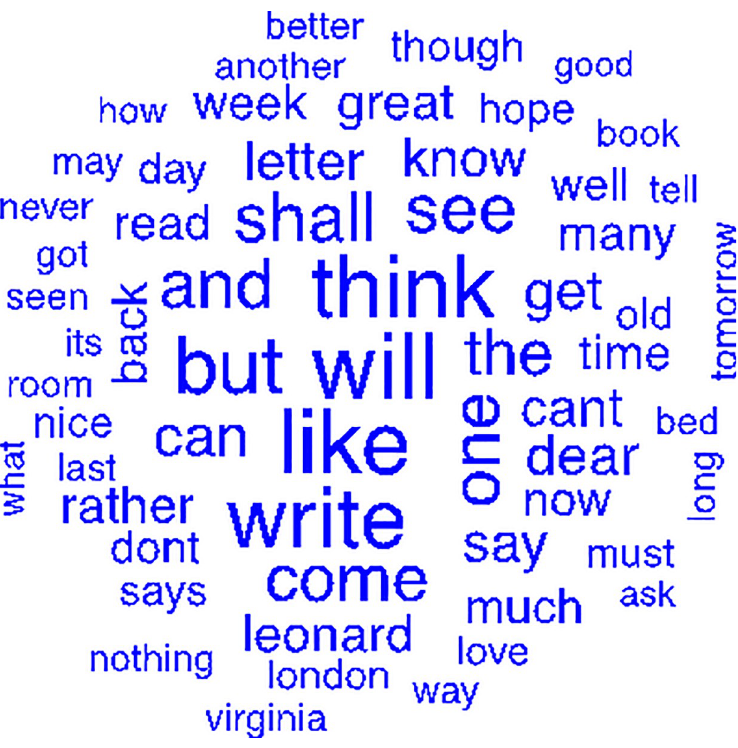
Fig 3. Word cloud of words written in randomly selected periods, outside the two months prior to Virginia Woolf’s suicide.